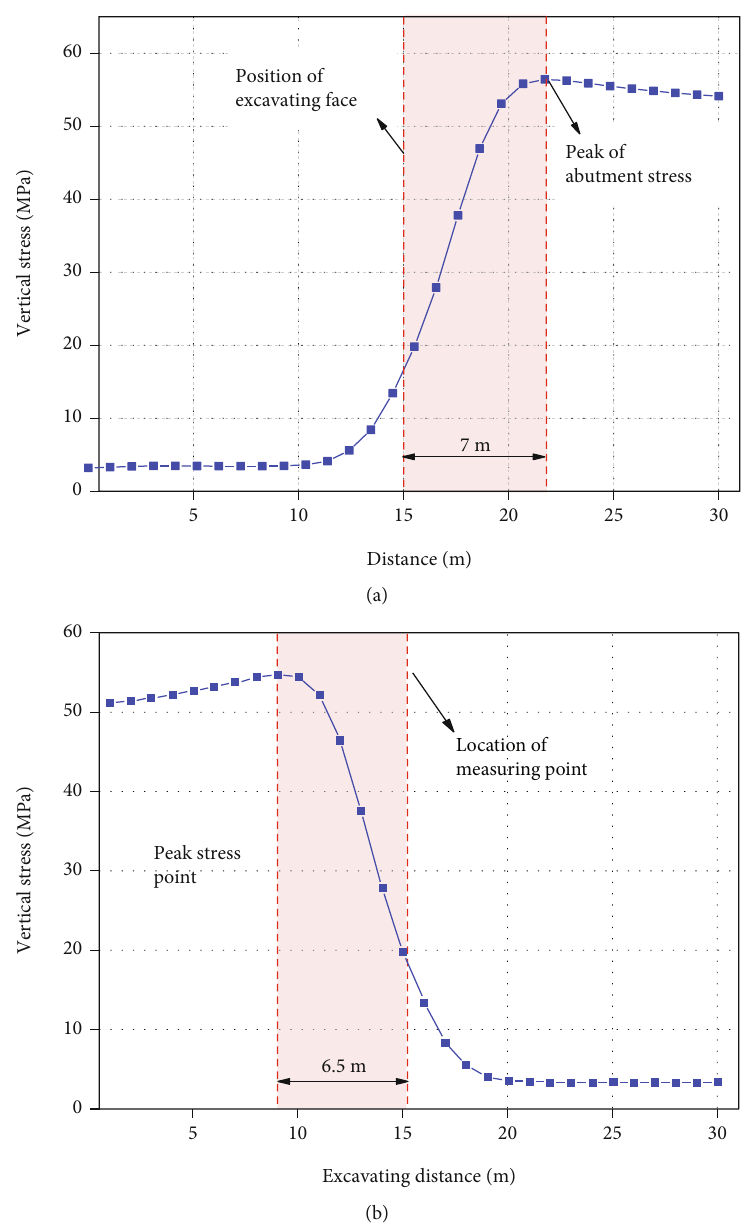
Figure 5: Characteristics of the roof stress disturbance during cyclic excavation of gob-side roadway: (a) the vertical stress distribution law of the roof along the axial direction of the roadway when the roadway is excavated to 15m and (b) the vertical stress evolution law of the roof at 15.5m of roadway mileage during 30m of roadway